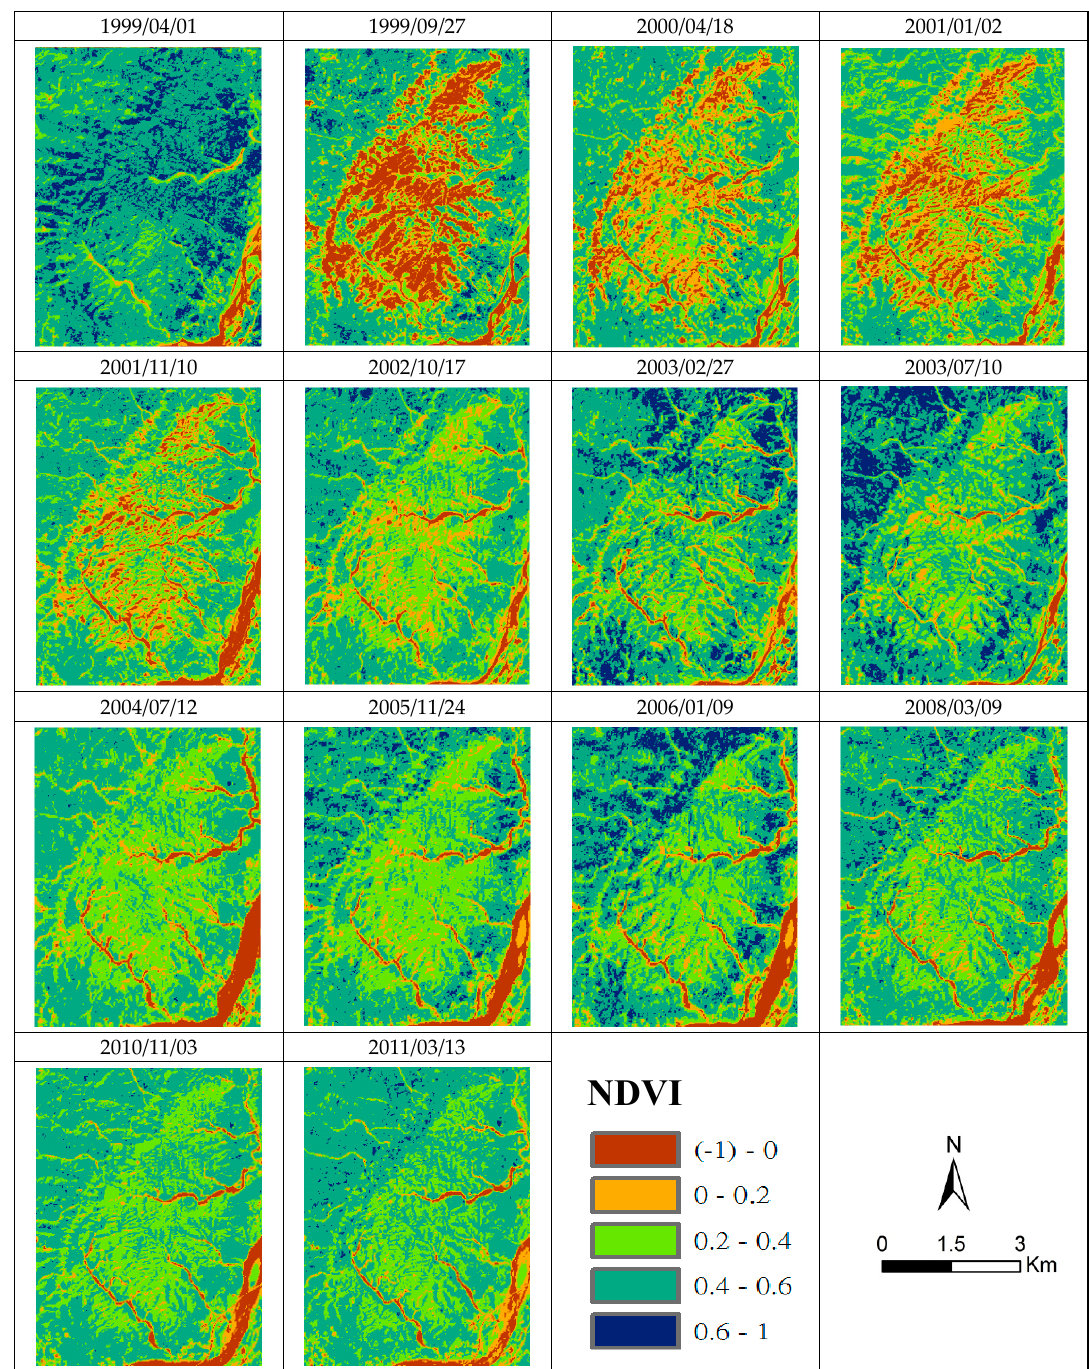
Figure 4. NDVI value of Mt. Jou-Jou SPOT satellite images. (Image latitude and longitude coordinates: Upper Left: 24.04°, 120.76°; Bottom Right: 23.98°, 120.81°)